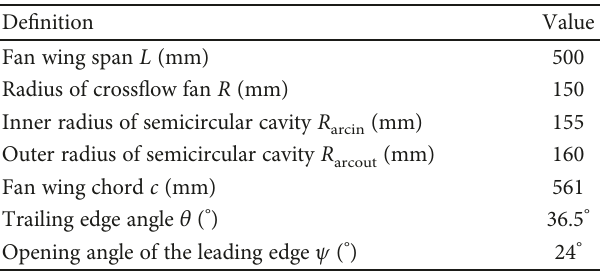
Table 1: De fi nition of fan wing geometric parameters.